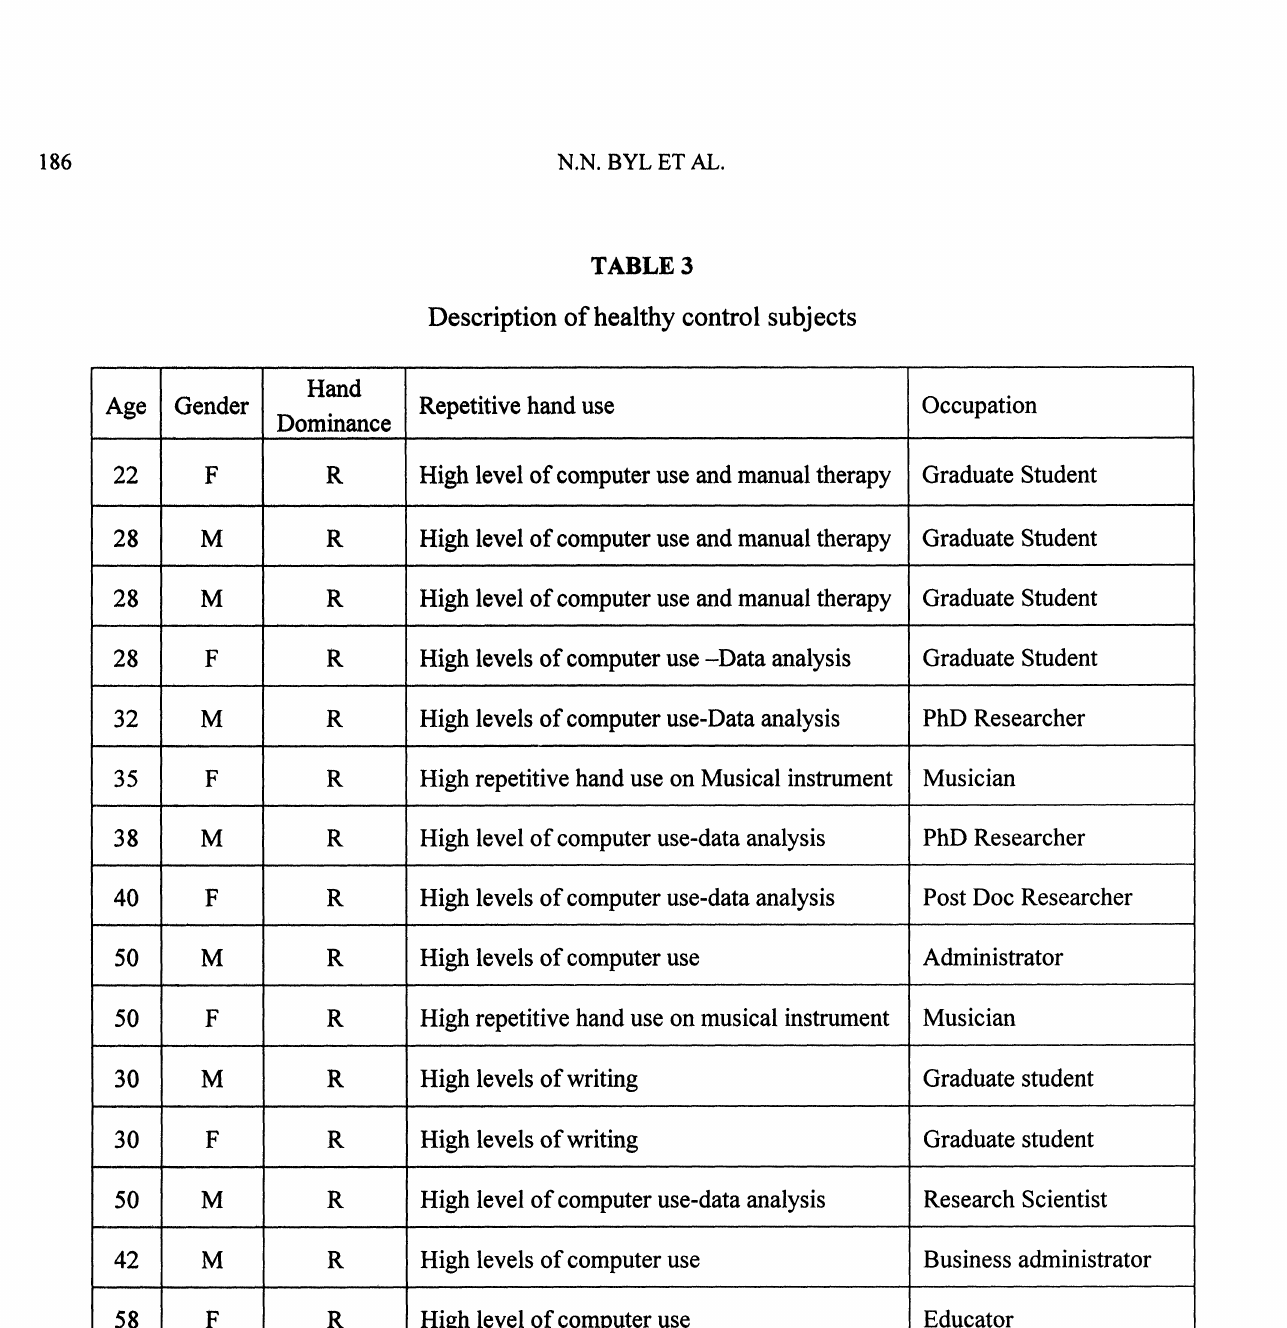
Description of healthy control